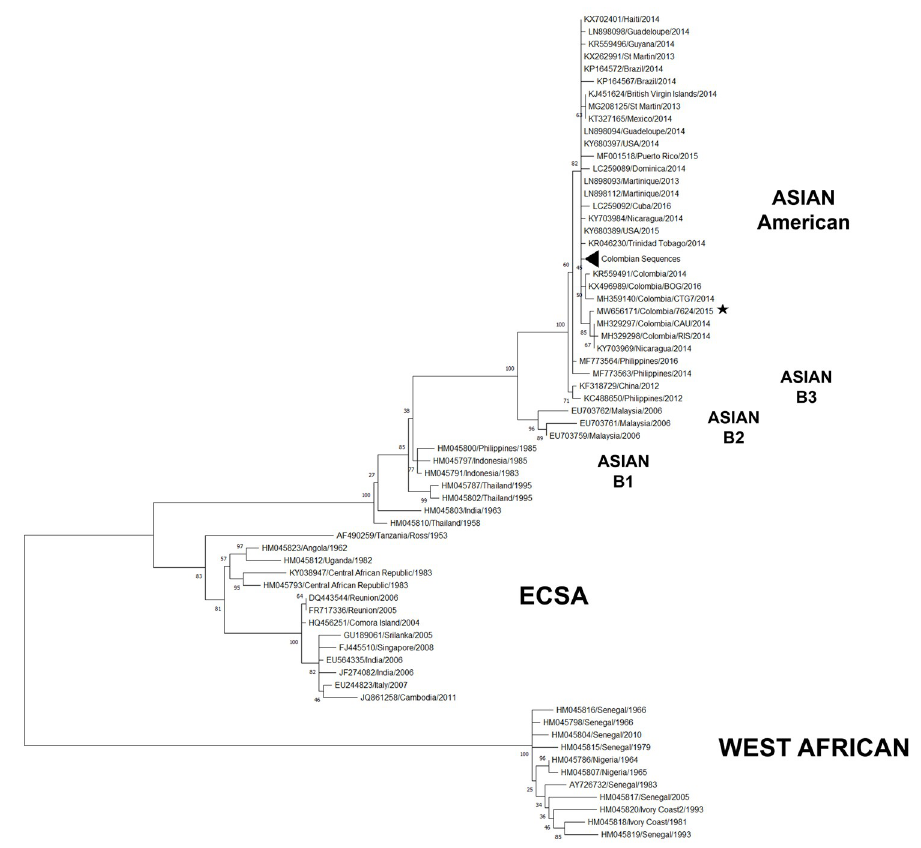
Fig 1. Phylogenetic analysis of Chikungunya virus. Full coding sequences of CHIKV were used. The maximum likelihood tree was constructed using the general time-reversible model and inferred following bootstrap analyses using 1,000 replicates. Strain names are in the format of: accession number/country /year of isolation. CHIKV genotypes: West African, Asian, and East/Central/South African (ECSA) are indicated on the right.